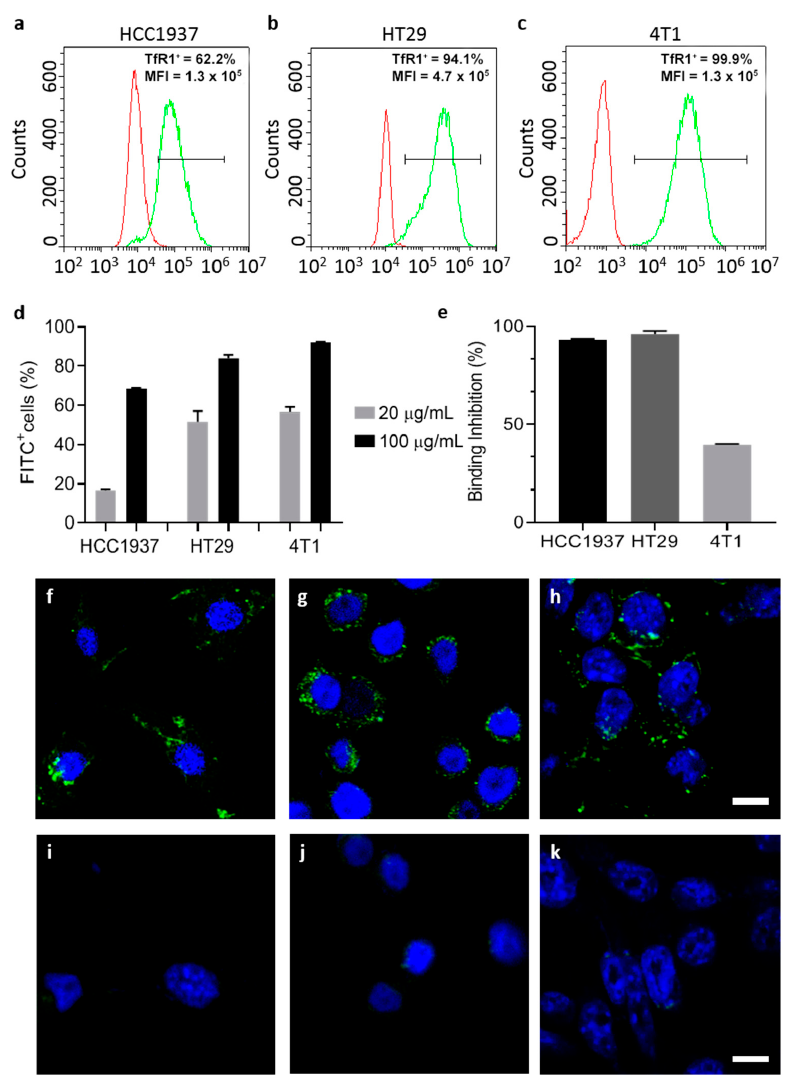
Figure 6. Cell interactions and uptake of ETX-free HFn. Representative histograms of TfR1 expression of selected cells (HCC1937, HT29 and 4T1) studied by flow cytometry ( a – c respectively) (TfR1 + : percentage of TfR1 positive cells, after setting proper fluorescence fates on non-stained cells; MFI: mean fluorescence intensity). Cells have been incubated with F-HFn at different concentrations at 4 ◦ C for 2 h and binding has been evaluated by flow cytometry showing that binding is correlated with TfR1 expression ( d ); competition assay showed reduced binding of HFn FITC when cells were pre-incubated with non-labelled HFn, confirming the TfR1 binding specificity ( e ); results in panels d and e are reported as average ± S.D. of 3 independent experiments. Confocal microscopy micrographs showing uptake of ETX-free F-HFn in HCC1937, HT29 and 4T1 after incubation with 100 µ g/mL of particles for 6 h ( f – h ). Cells were incubated with the same concentration of free FITC for 6 h and the signal was almost undetectable ( i – k ) F-HFn and FITC are represented in green, while nuclei labelled by DAPI are colored in blue. Scale bar 10 µ